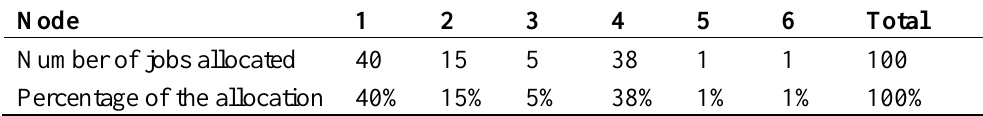
Table 12. Numbers of jobs allocated to resource nodes.